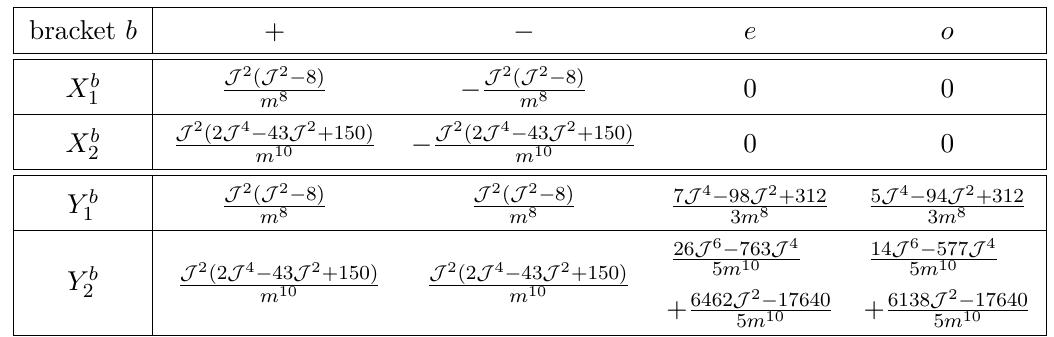
Table 5 . Solving the sum rules gives the EFT coefficients in terms of brackets. Below are the terms which appear in each bracket in the